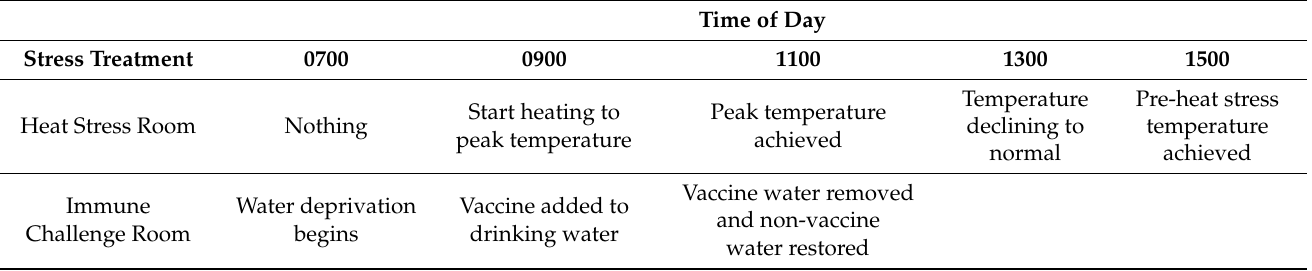
Table 4. Timeline of imposed heat stress and immune challenge treatments on the treatment day. Time of